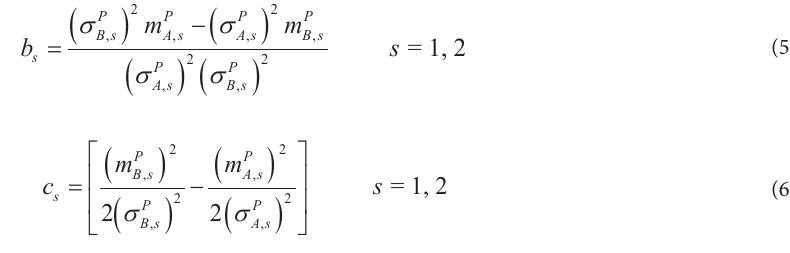
As it is observed in Eq. 2, the likelihood ratio is monotonically increasing with Z , so the latter can be used to calculate the implies that Λ > Λ . For this reason, Z is established as SDS. Eq. 3 shows the quadratic decision threshold directly, since Z > Z 0 0 dependence of the moments presented by Z and it should be noted how the coefficients of Eq. 4 to Eq. 6 depend on the population means and variances of both classes, which causes different second-order surfaces for different anomaly and background pairs. is satisfied, is Finding the points in the moment space (plane in the two-dimensional case), for which the condition Z = Z 0 . This projection would be the curve that determines equivalent to finding the projection of the cut between Z and plane Z = Z 0 the decision boundary, whose exact shape depends on the coefficients in Eq. 4 to Eq. 6, resulting in ellipses or hyperbolas as shown in Fig. 1.